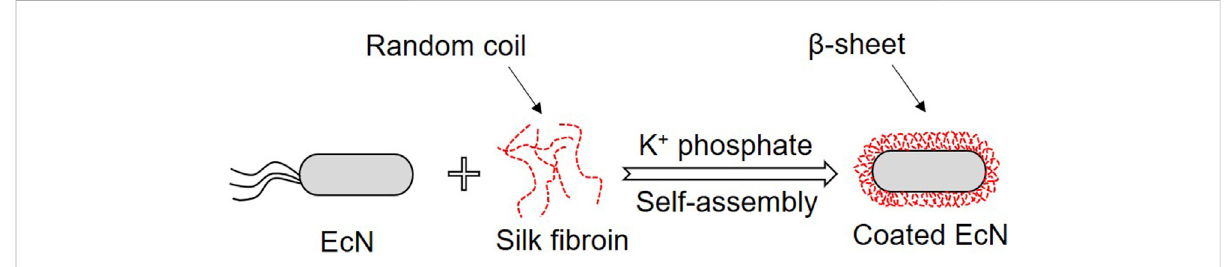
FIGURE 3 Schematic diagram of decorating bacteria with medicative silk fi broin by self-assembly.